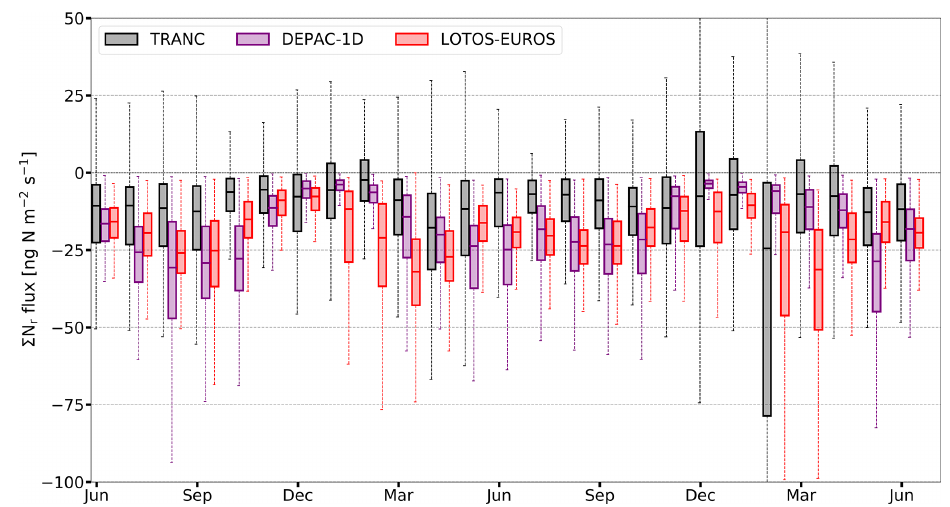
Figure 6. Fluxes of DEPAC-1D (purple), LOTOS-EUROS (red), and TRANC (black) from June 2016 to June 2018, shown as box-and- whisker plots. Whiskers of TRANC fluxes cover the range from − 191 to 105ngNm − 2 s − 1 in February 2018; the upper whisker of December 2017 reached 69ngNm − 2 s − 1 .